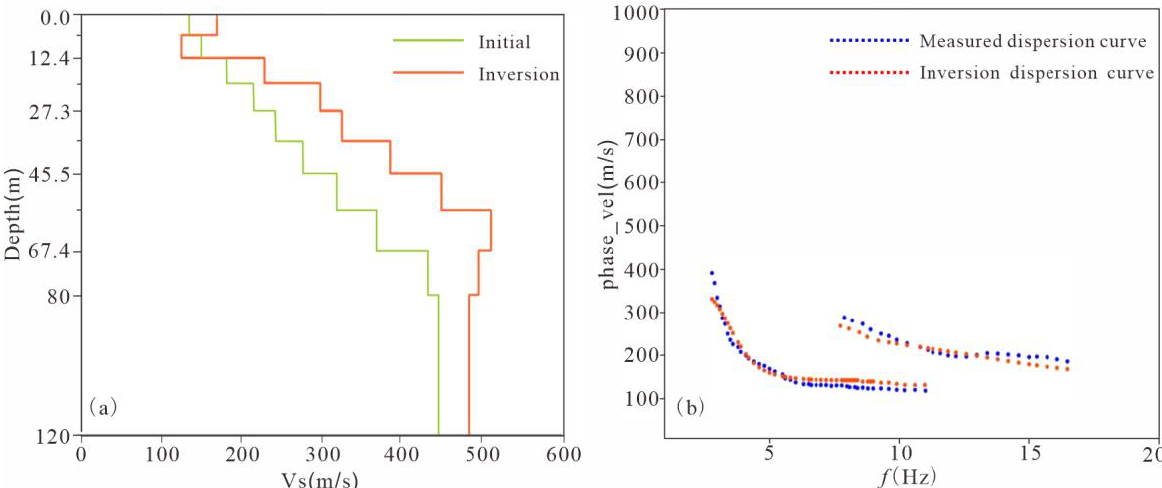
Figure 7. Joint inversion results of fundamental and higher-mode curves. ( a ) S-wave velocity structure of fundamental and higher-mode inversion. ( b ) Dispersion curve of the inversion in the fundamental and first higher-mode fitting the measured data dispersion curve.